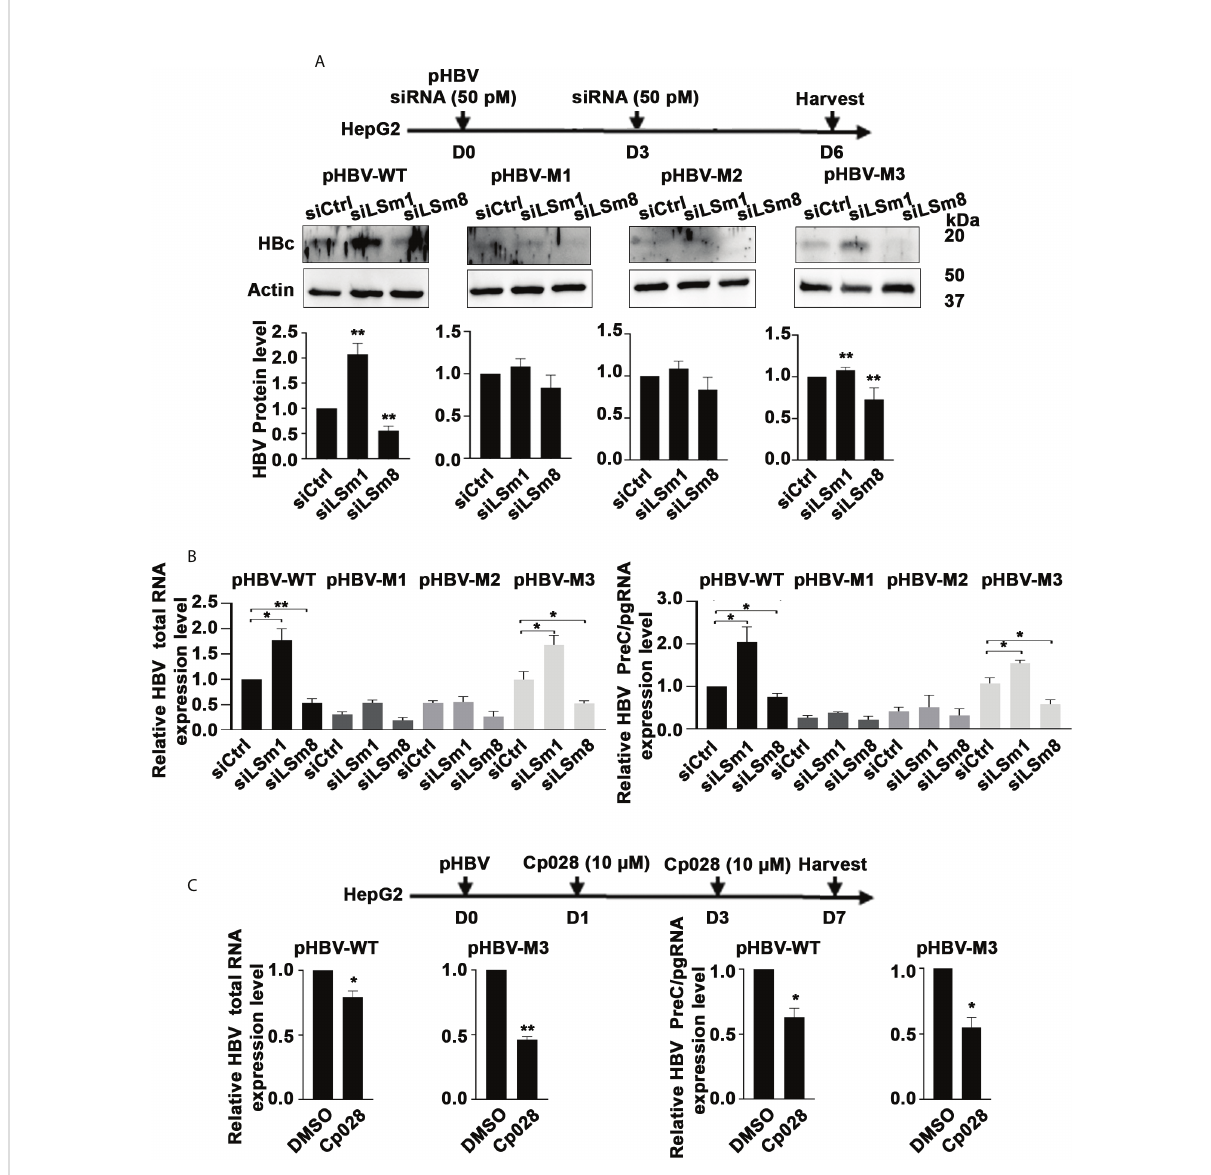
FIGURE 5 Opposite effects of the LSm1-7 vs. LSm2-8 complexes on HBV biosynthesis. (A) Timeline of transfections of 1.3mer HBV plasmid DNA and 50 pM of indicated siRNAs in HepG2 cells. pHBV-WT, pHBV-M1, pHBV-M2 and pHBV-M3 (1.0µg each per 6-well plate) transfected by lipofectamine3000 in HepG2 cells. HBc immunoblot of day6-transfected HepG2 lysates. Panels below immunoblots show quanti fi cation of HBc by ImageJ software from three independent experiments. *p<0.05, **p<0.01 (B) RNA isolated from transfected cells in (A) used for RT-PCR quanti fi cation of total HBV RNA and preC/pgRNA. n=3 *p<0.05, **p<0.01 C. Timeline of transfection of 1.3mer HBV plasmid DNA in HepG2 cells, in combination with Cp028 (10µM) treatment. pHBV-WT and pHBV-M3 (1.0µg each per 6-well plate) transfected by lipofectamine3000 in HepG2 cells. HBc immunoblot of HepG2 lysates shown in Supplementary Figure S5. RNA isolated from transfected cells in (C) used for RT-PCR quanti fi cation of total HBV RNA and preC/pgRNA. n=3 *p<0.05,